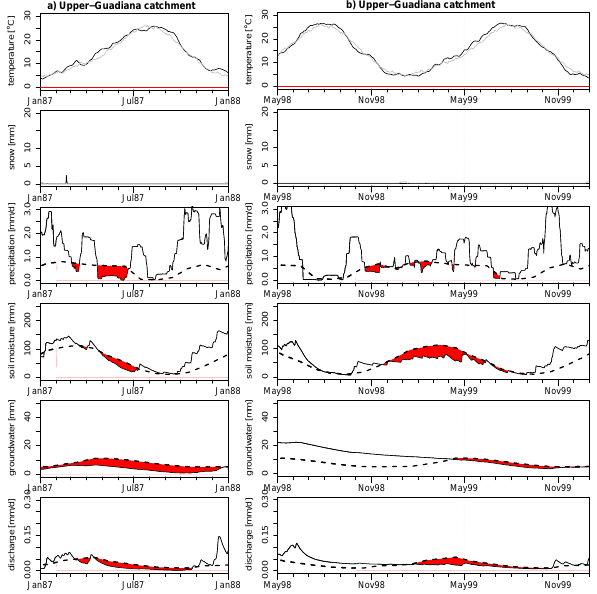
Fig. 7. Examples of wet-to-dry-season drought type: (a) Upper- Guadiana catchment 1987, (b) Upper-Guadiana catchment 1998– 1999 (legend: see Fig.